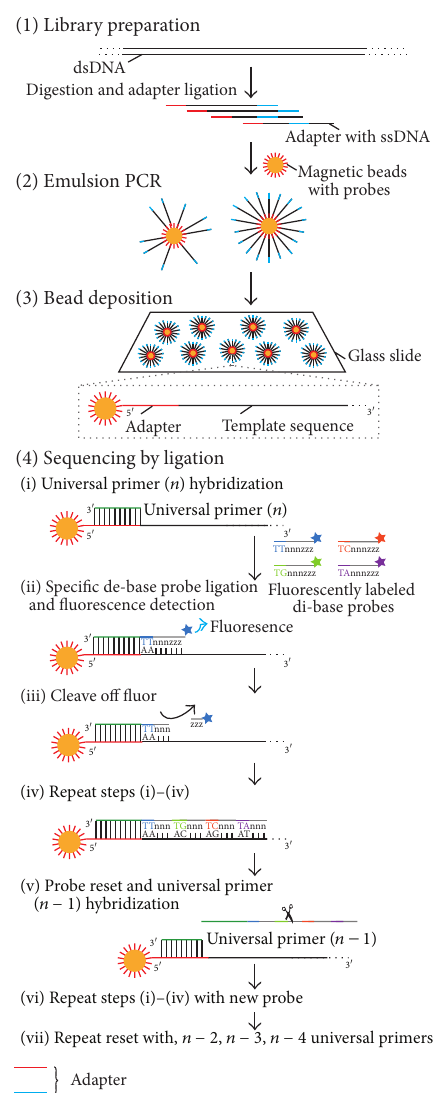
Figure 8: The ligase-mediated sequencing approach of the Sequence by Oligonucleotide Ligation and Detection (SOLiD) sequencer (Life Technologies). (1) Library preparation: two different adapters are ligated to sheared genomic DNA. (2) Emulsion PCR: emulsion PCR is conducted using magnetic beads to generate “bead clones,” in which each contains a single nucleic acid species. (3) Bead deposition: the beads are then attached to the surface of a glass slide. (4) Sequencing by ligation: ligase-mediated sequencing begins by annealing a universal primer to the shared adapter sequences on each amplified fragment (i), and then DNA ligase is provided along with specific fluorescently labeled 8-mers, in which the two bases at the 3 󸀠 end of the probe are encoded by the attached fluorescent group. Each ligation step is followed by fluorescence detection (ii), after which a regeneration step removes the bases from the ligated 8-mer (including the fluorescent group) (iii), and concomitantly prepares the extended probe for another round of ligation (iv–vii). Since each fluorescent group on a ligated 8-mer identifies a two-base combination, the resulting sequence reads can be screened for base-calling errors versus either true polymorphisms or single base deletions, by aligning the individual reads to a known high-quality reference